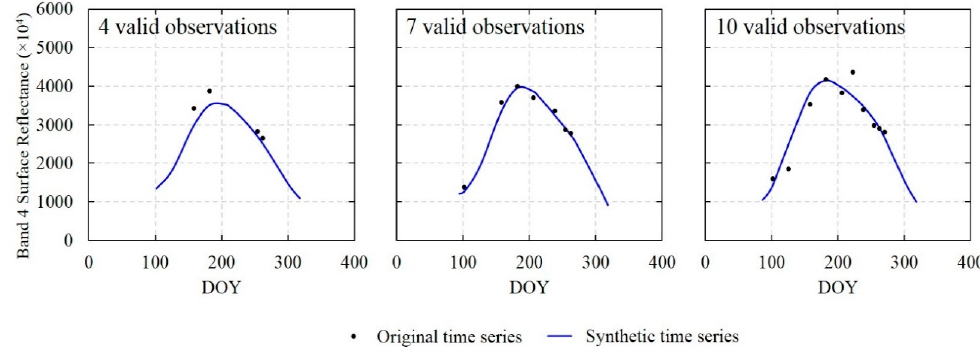
Figure 9. Illustration of Landsat band-4 time-series of deciduous forest samples with different numbers of valid observations during the year 2011. (The black dots indicate original time-series observations and blue curves indicate synthetic time-series).